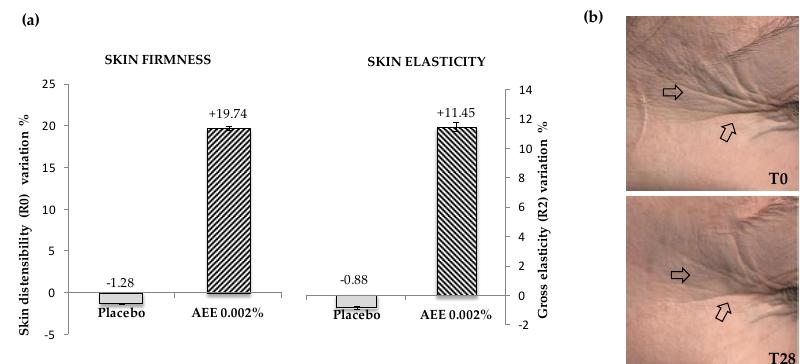
Figure 5. Clinical tests on human skin. 20 female volunteers were treated for 28 days either with a cream containing 0.002% of AEE or with a placebo cream without the extract. The effects on skin firmness and elasticity were measured by a Cutometer and expressed in the graph as R0 and R2 parameters ( a ). The effects on wrinkle depth were visualized by a 3D camera and photographed ( b ). The error bars indicate standard deviations, * p < 0.05 compared to placebo